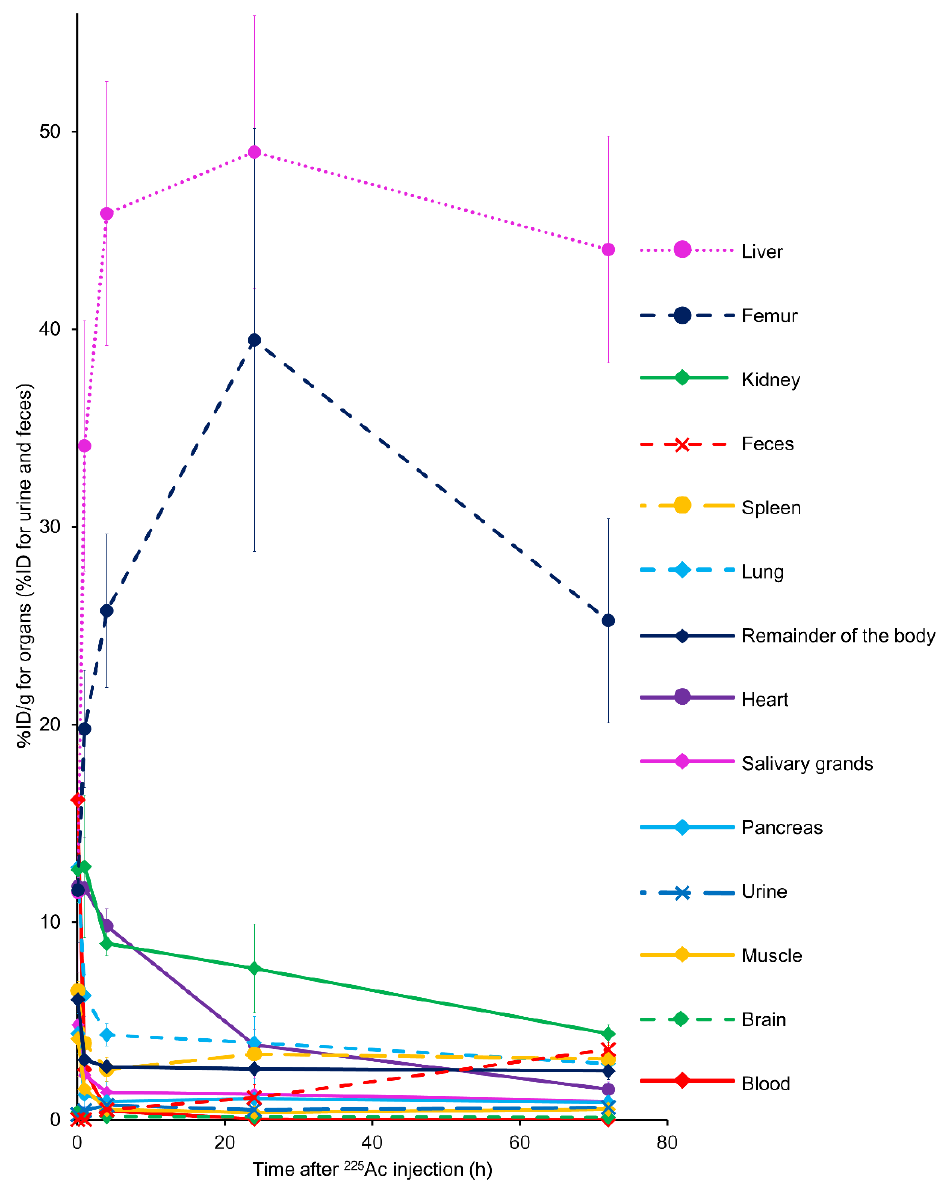
Figure 4. Biodistribution of free actinium-225 ( 225 Ac) in BALB/c mice. Data were obtained at 5 min, 1 h, 4 h, 24 h, and 72 h after intravenous 225 Ac injection. Values are expressed as % ID/g for the organs and blood and as the % ID for urine and feces. Values are shown as the mean ± SD ( n = 4).